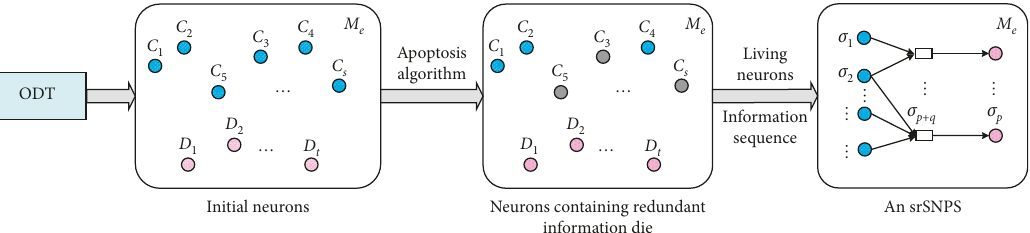
Figure 2: Diagram of evolutionary process of an srSNPS.